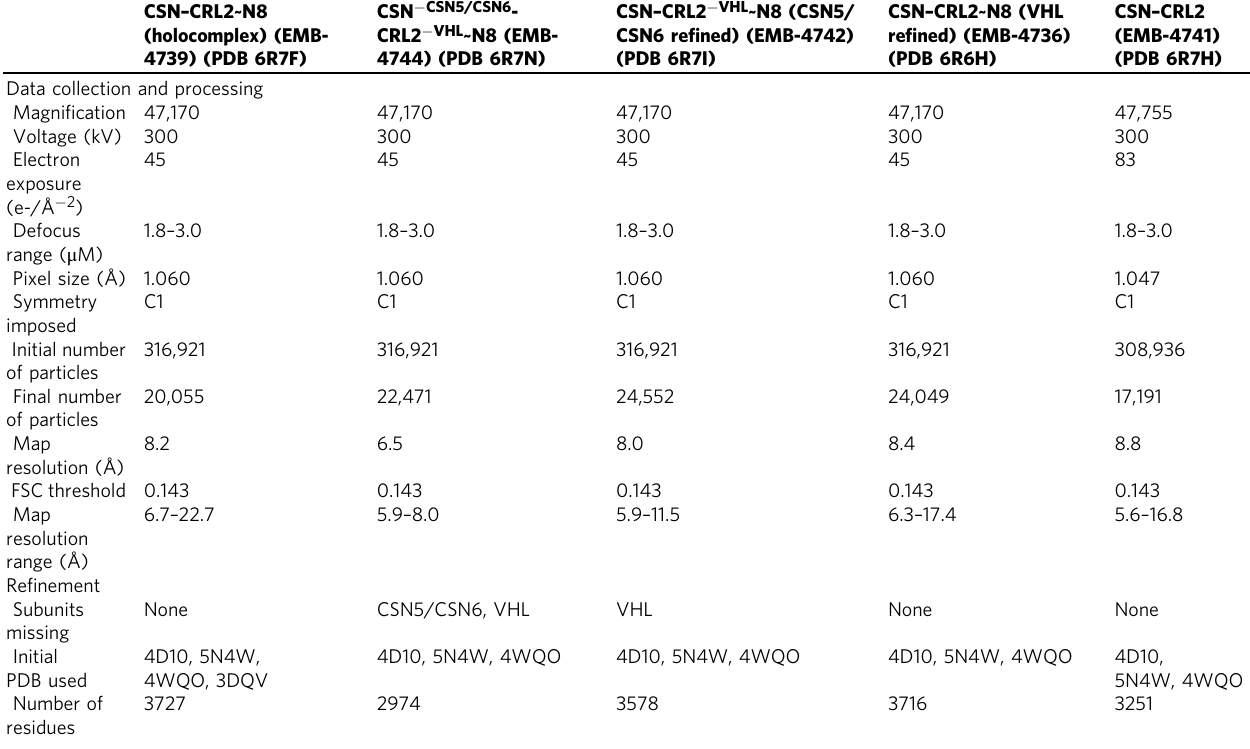
Table 1 Cryo-EM data collection, re fi nement and validation statistics CSN – CRL2~N8 (holocomplex)